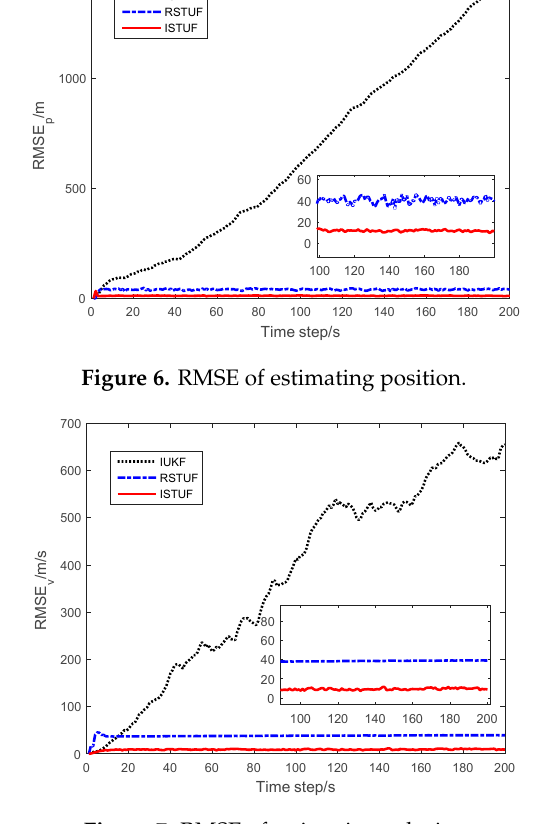
Figure 7. RMSE of estimating velocity.